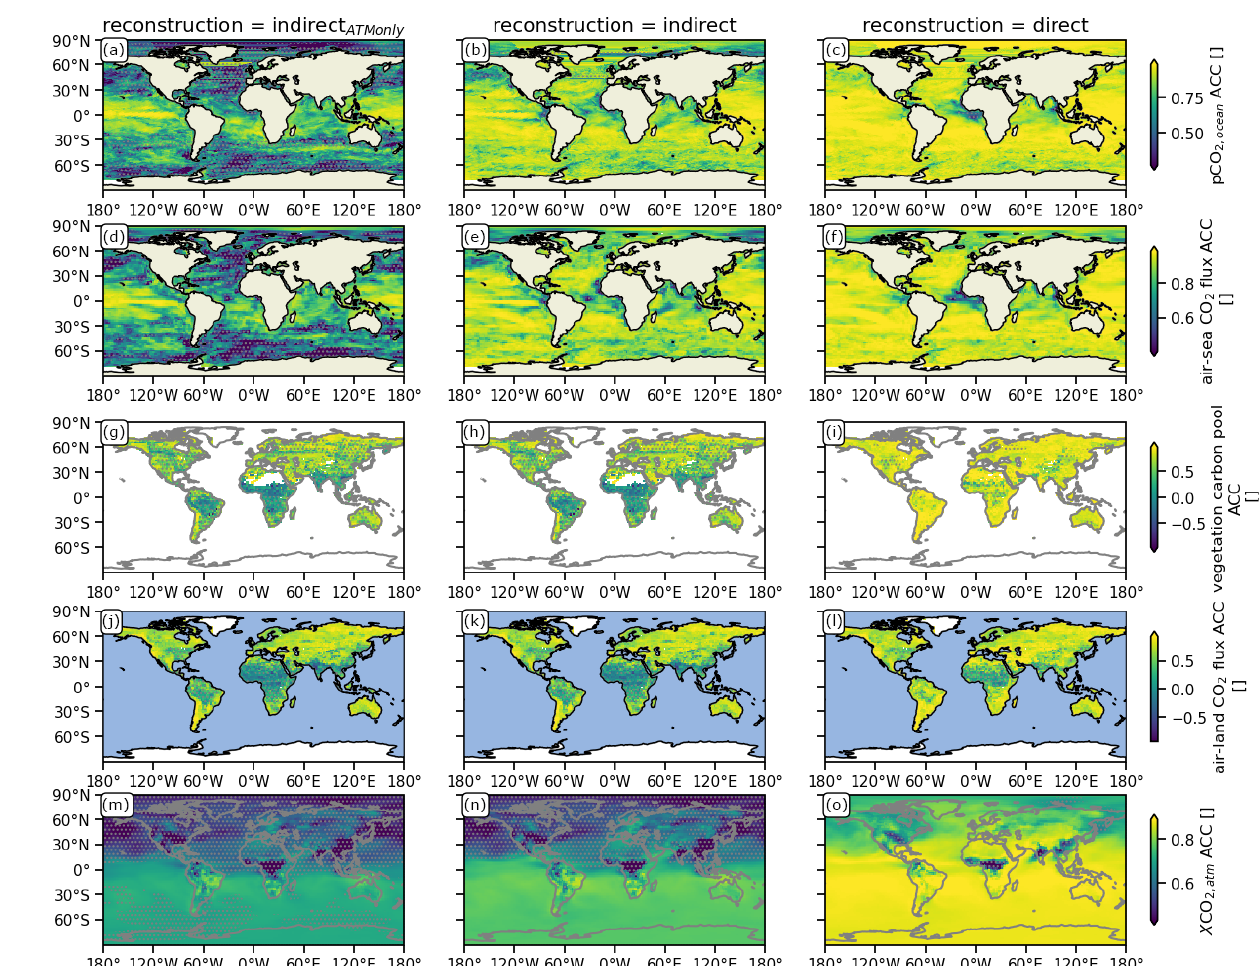
Figure 3. The same as Fig. 2 but for the anomaly correlation coefficient (ACC). Gray stippling shows where the ACC is lower than the 95th-percentile ACC threshold from random target block resampling, i.e., the reconstruction is not significantly better than a resampling internal variability